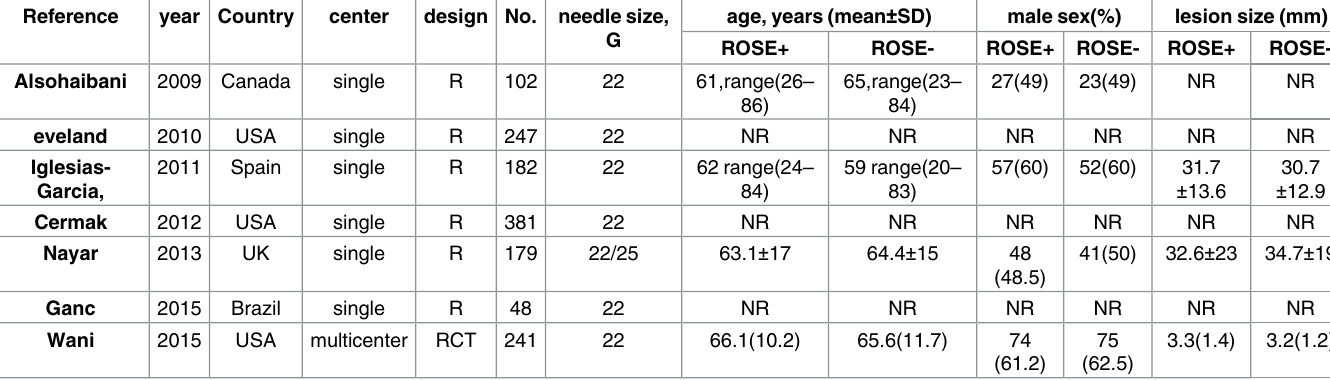
Table 1. Characteristics of patients and studies included in the meta-analysis comparing EUS-FNA with and without ROSE. Reference